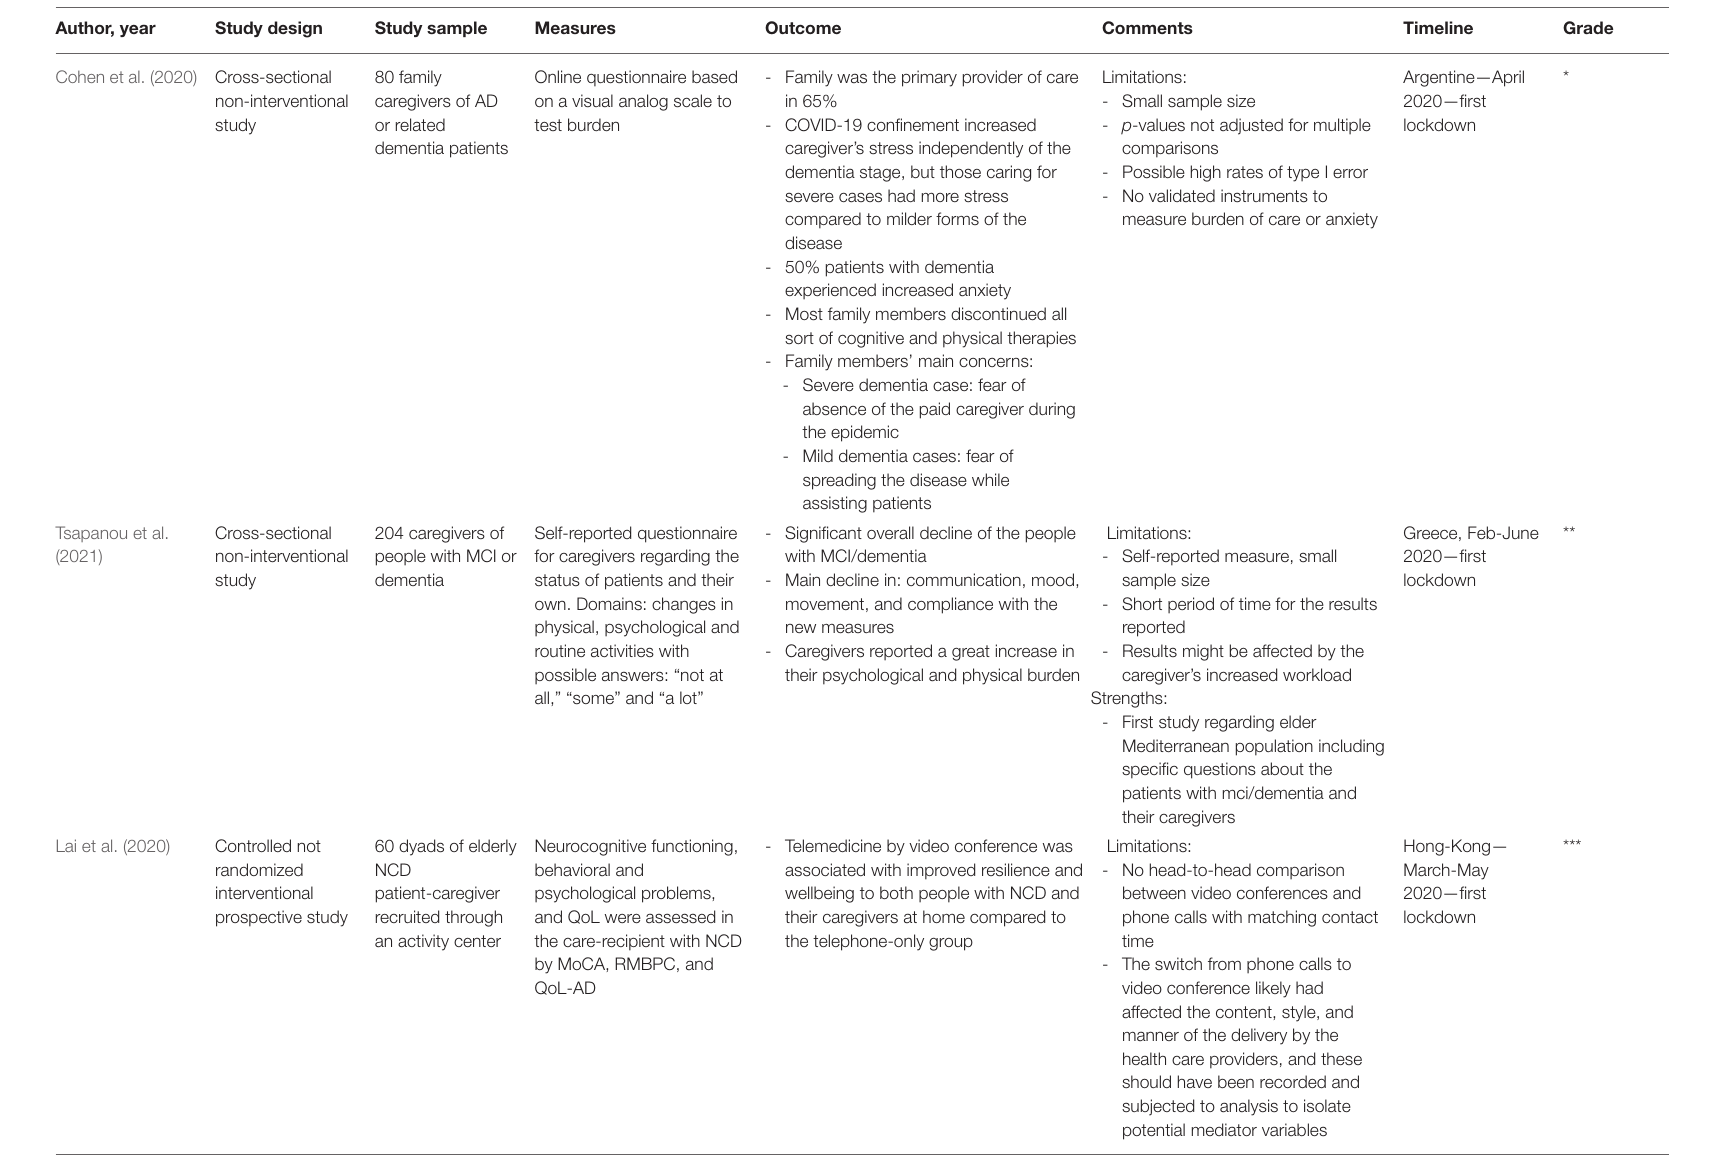
TABLE 1 | The main characteristics of included studies in the